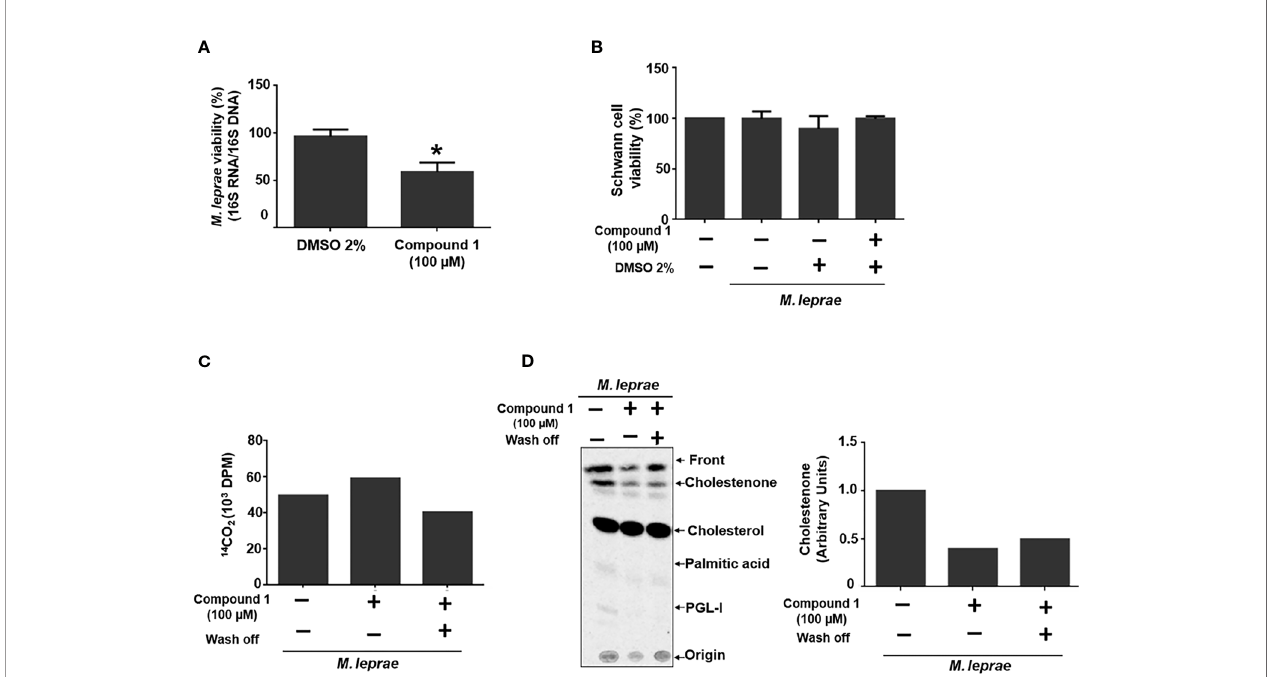
FIGURE 3 | 3 b -HSD inhibition impacts M. leprae intracellular survival. (A, B) ST88-14 SCs were infected (MOI 5:1) for 24 h at 33°C with M. leprae pre-treated for 6 h with vehicle (2% DMSO) or 100 µM compound 1. (A) M. leprae intracellular viability was determined by qRT-PCR. (*p < 0.05 - by Mann-Whitney test)(n=5) (B) SC viability was measured by MTT assay (n=3). (C, D) M. leprae was incubated in axenic medium with 100 µM compound 1, 1µCi/mL of [26- 14 C]cholesterol and 1µCi/mL of [1- 14 C] palmitic acid for 6 h at 30°C followed by centrifugation and wash and removal of compound 1 (wash off, +) or replacement with fresh medium containing compound 1 (wash off, -), and incubation for 24 h at 33°C. (C) M. leprae viability was measured by radiorespirometry (n=1). (D) Radiolabeled lipids were resolved by TLC with chloroform-methanol 95:5 (v/v) as mobile phase and observed with a PhosphorImager. The graph indicates corresponding densitometry of cholestenone bands